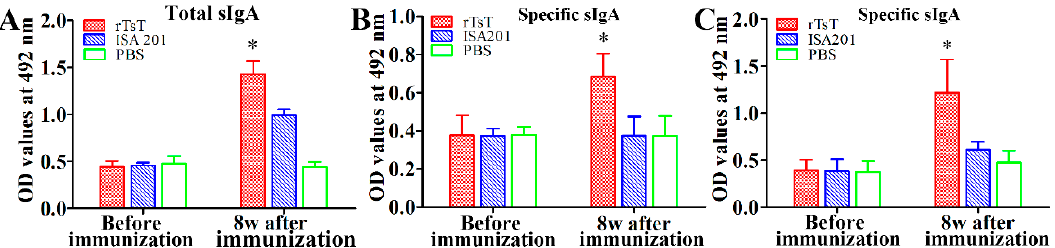
Figure 10. Levels of total sIgA ( A ), anti-TsT specific sIgA in enteral fluid of vaccinated mice assayed by ELISA using ML crude antigens ( B ) and rTsT ( C ). The data are the mean ± SD for 5 mice per group. * Significantly different compared with the ISA 201 or PBS group (* p < 0.01).